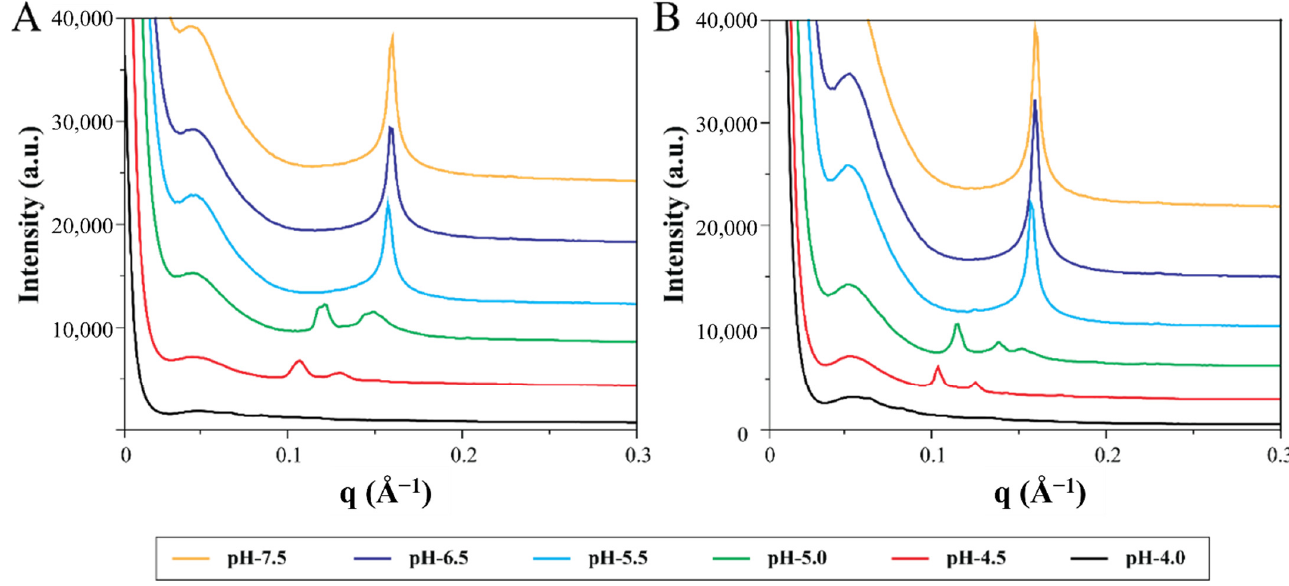
Figure 5. Representative one-dimensional SAXS profiles for nanoparticles prepared by doping OAPy-4 to MO at R AL = 0.4 at 37 °C ( A ) and at room temperature ( B ).